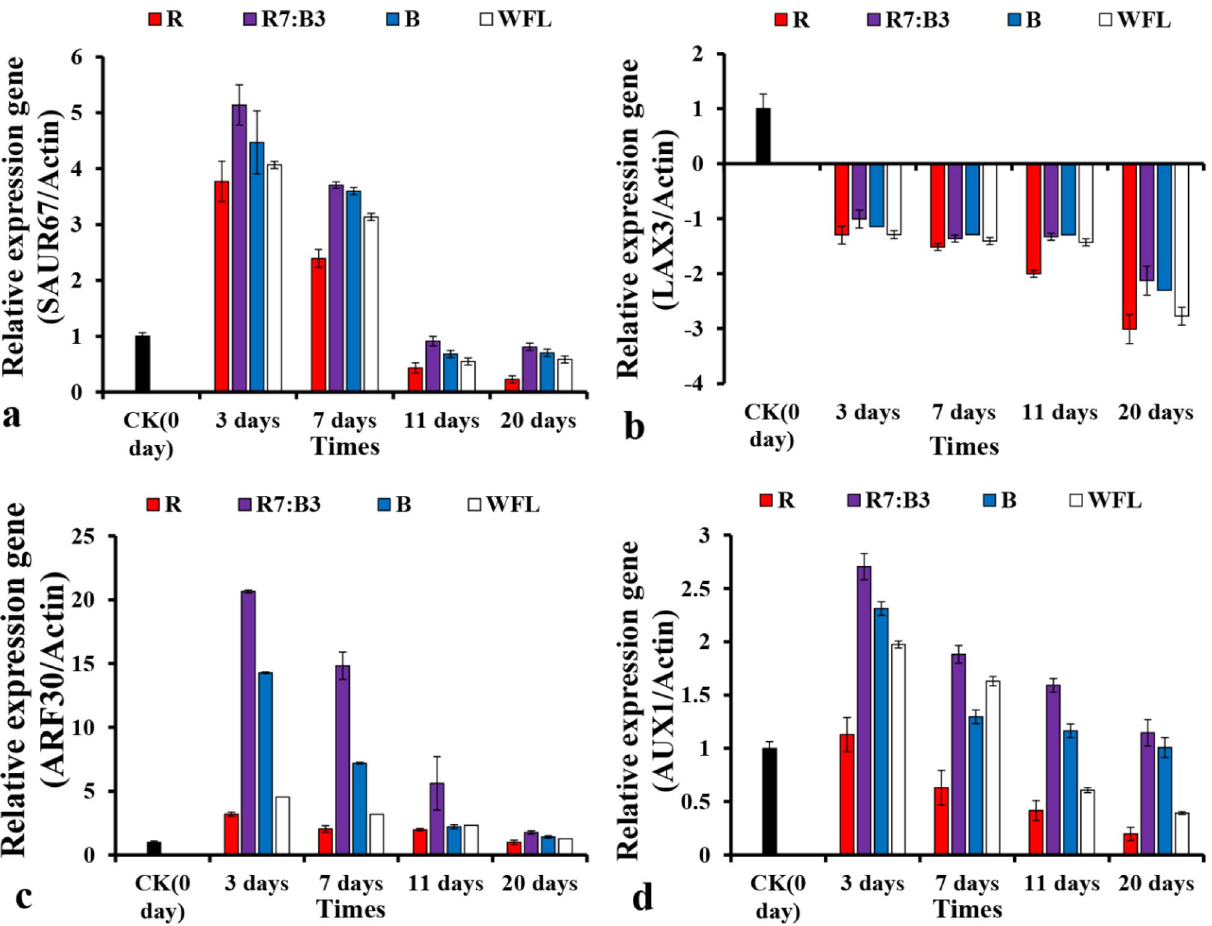
Figure 7. Relative expression of (SAUR67) ( a ); Relative expression of (AUX1) ( b ); Relative expression of (ARF30) ( c ); and Relative expression of (LAX3) ( d ) at different time points. The different letters show significant differences among light treatments according to the Duncan test (P <